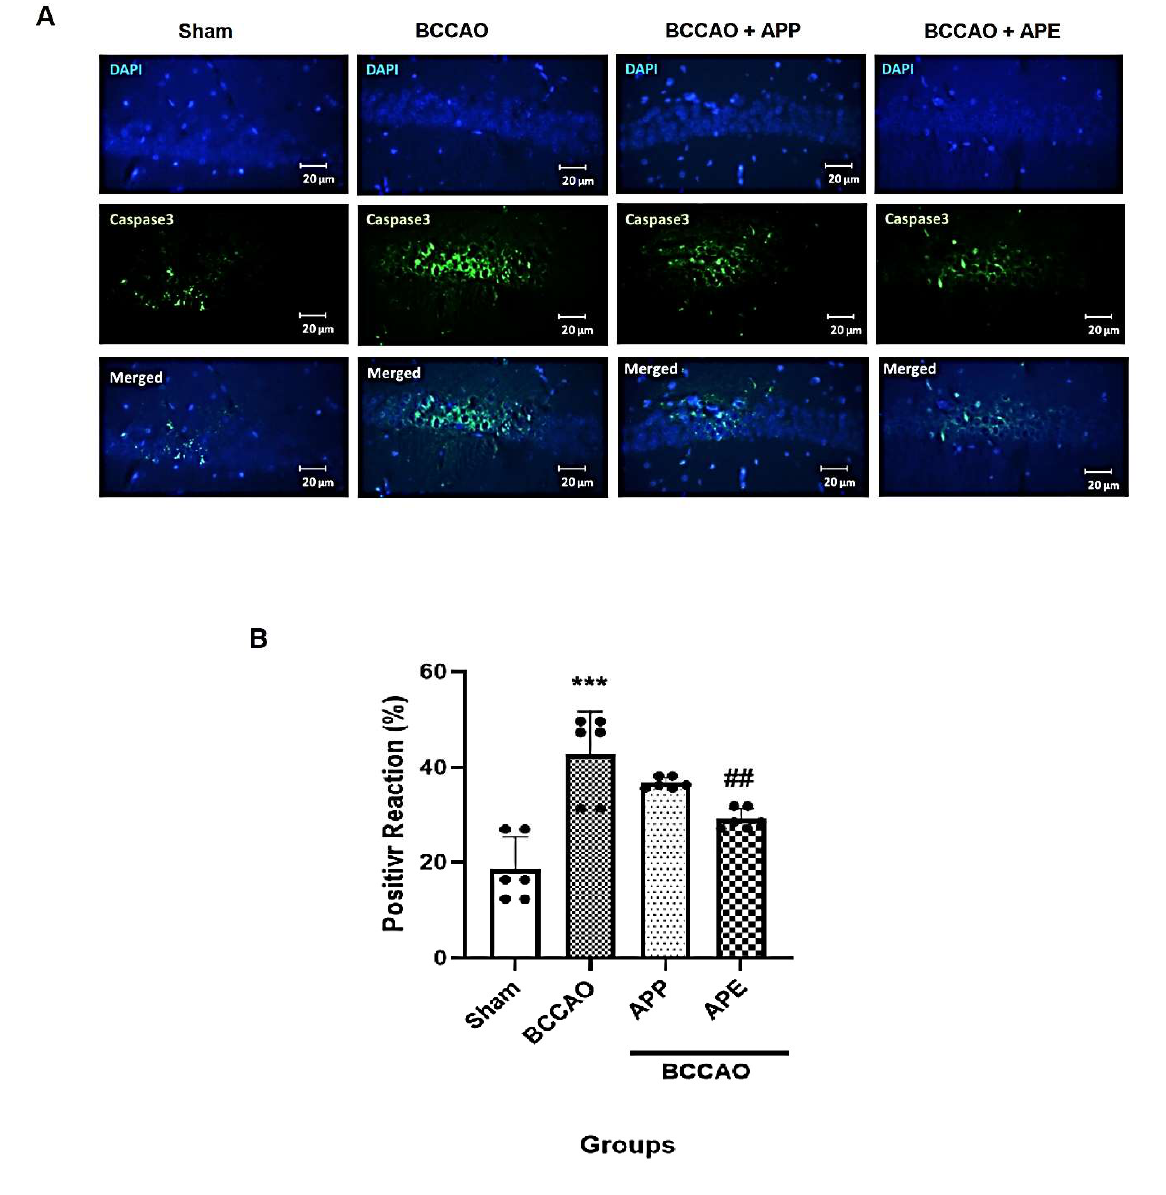
Figure 6. APE reduced the number of caspase-3 expressing cells in hippocampi. ( n = 6). ( A ) Microphotographs show the co-localization of caspase-3 (green)-positive cells with DAPI (blue) in hippocampi of animals. ( B ) Semi-quantitative assay of active caspase-3. Results are mean ± SD. Repeated measures one-way analysis of variance with Bonferroni post-hoc was used. *** p < 0.001 vs. the sham group, ## p < 0.01 vs. the BCCAO group.